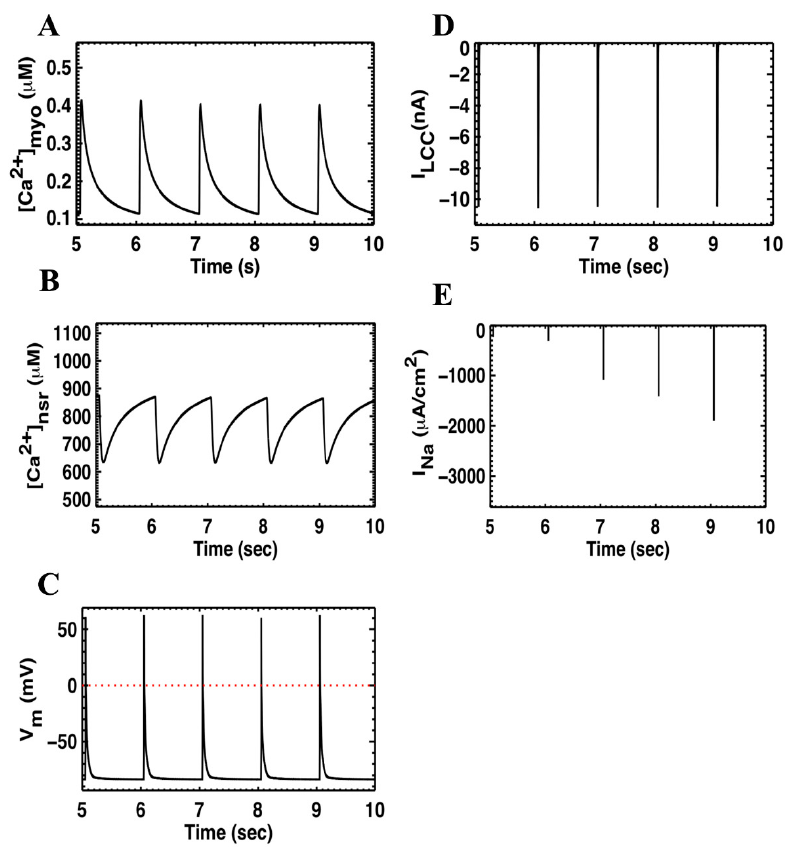
Figure 4. A long trace of calcium dynamics in the ( A ) myoplasmic [Ca 2+ ], ( B ) network SR [Ca 2+ ], and ( C ) Action Potential, ( D ) L-type current density, and ( E ) Sodium current